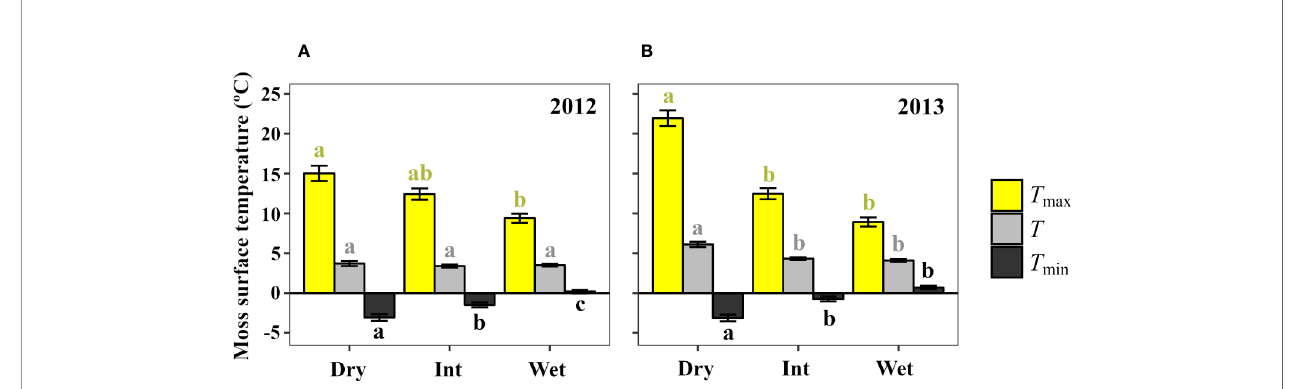
FIGURE 6 | Daily moss surface temperature mean ( T ), maximum ( T max ) and minimum ( T min ) in dry, intermediate and wet environments (3 sensors each) across a S. antarctici moss bed near Casey station (East Antarctica) during two summer seasons: data from (A) 29/12/2011 to 26/01/2012 (87 days), and (B) 13/01/2013 to 31/01/2013 (54 days). Data are means ± se. Different letters denote signi fi cant differences between environments by Duncan post-hoc ( P < 0.05).